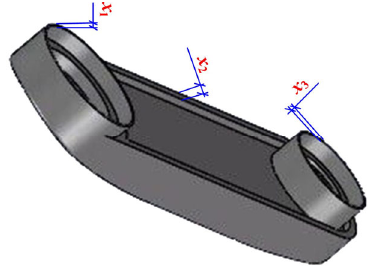
Figure 11. Geometrical structure of the big arm.